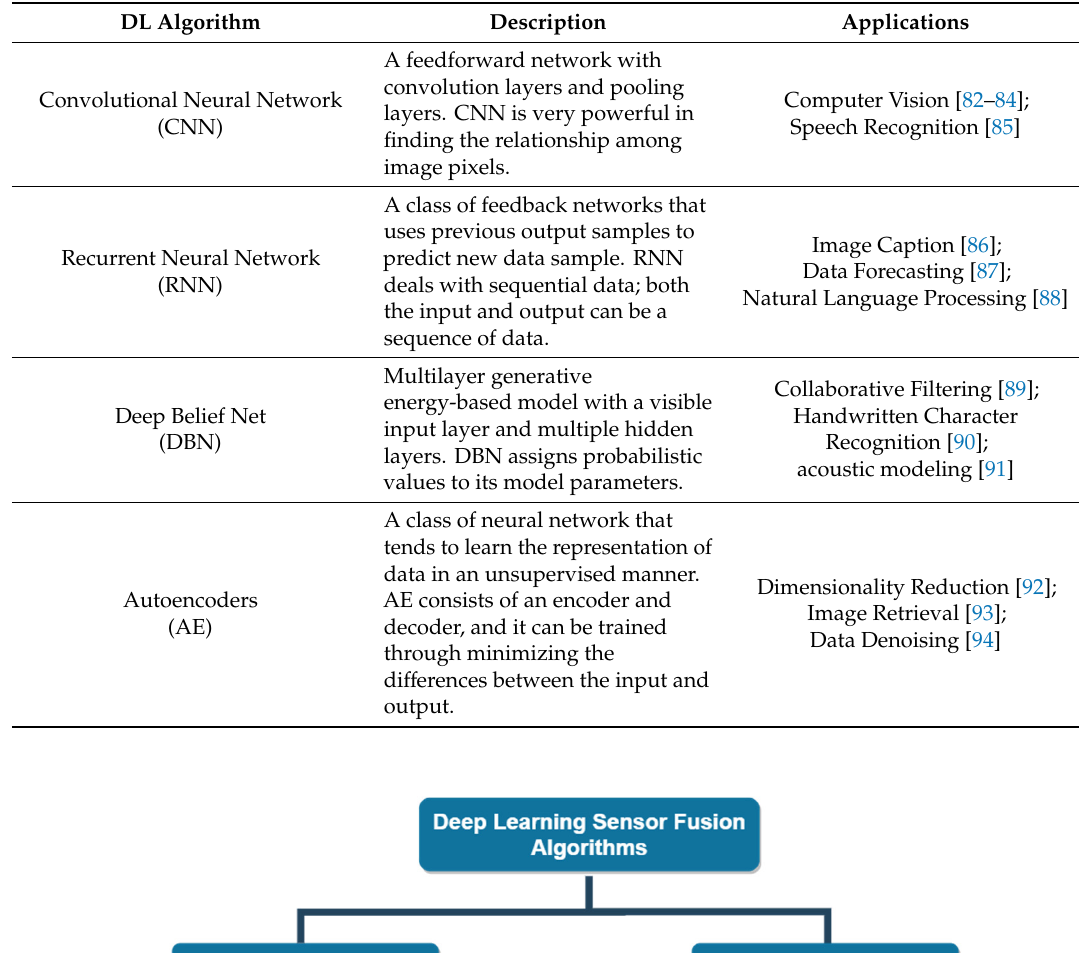
Table 3. A summary of di ff erent deep learning algorithms, their main properties, and applications.